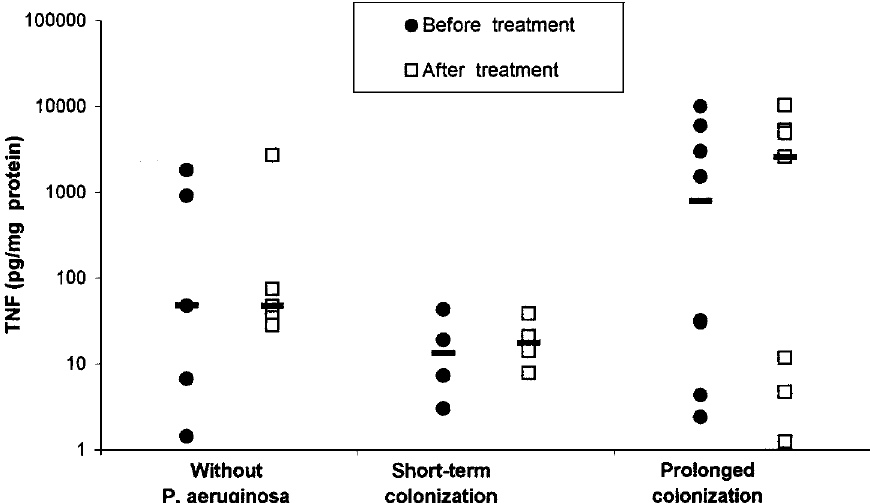
FIG. 4. TNF- a levels in the lungs of CF patients with different P. aeruginosa status. Sputum samples were obtained from CF patients before and after antibiotic treatment. A cytokine concentration was determined using the biological test as described in Material and Methods. Median values are indicated by the lines. Each dot represents one patient. Data reported were compared by unpaired, two-tailed Student’s t -test. There were no statistically significant differences between patient groups.